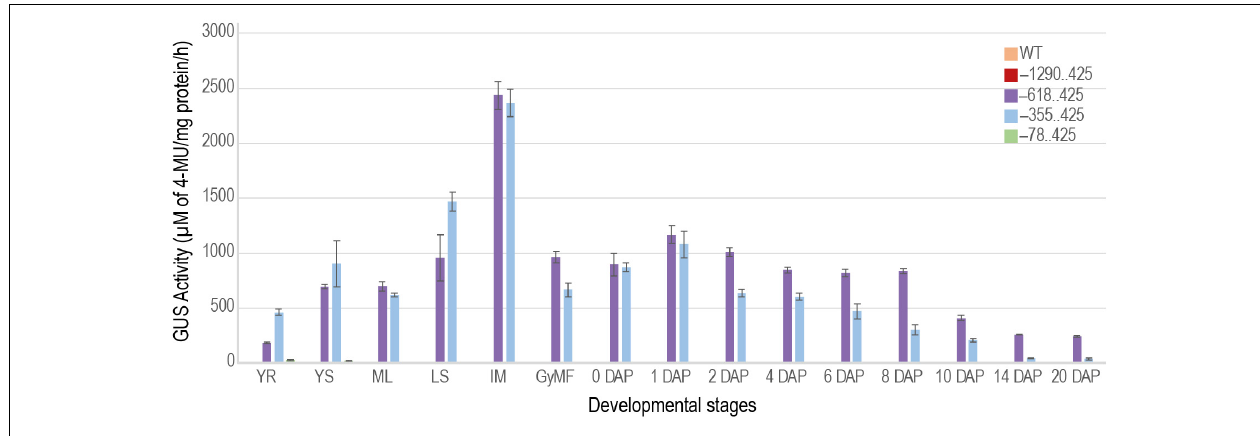
FIGURE 9 | Quantitative measurement of GUS activity during different stages of development. Bar graph showing GUS activities obtained for –1290..425, –618..425, –355..425, and –78..425 constructs. The GUS activity measured in the WT was used as a control. YR and YS, young root and young shoot from 7-day-old light-grown seedlings; ML, mature leaf; LS, leaf sheath; IM, intercalary meristem from ∼ 60-days-old plants. Reproductive stages are represented by GyMF, gynoecium of mature floret; and seeds from 0–20 days after pollination (DAP) stages. The GUS activity is represented as µ M of 4-MU/mg protein/h. Data represent information obtained from three biological replicates. Error bars represent the standard error.